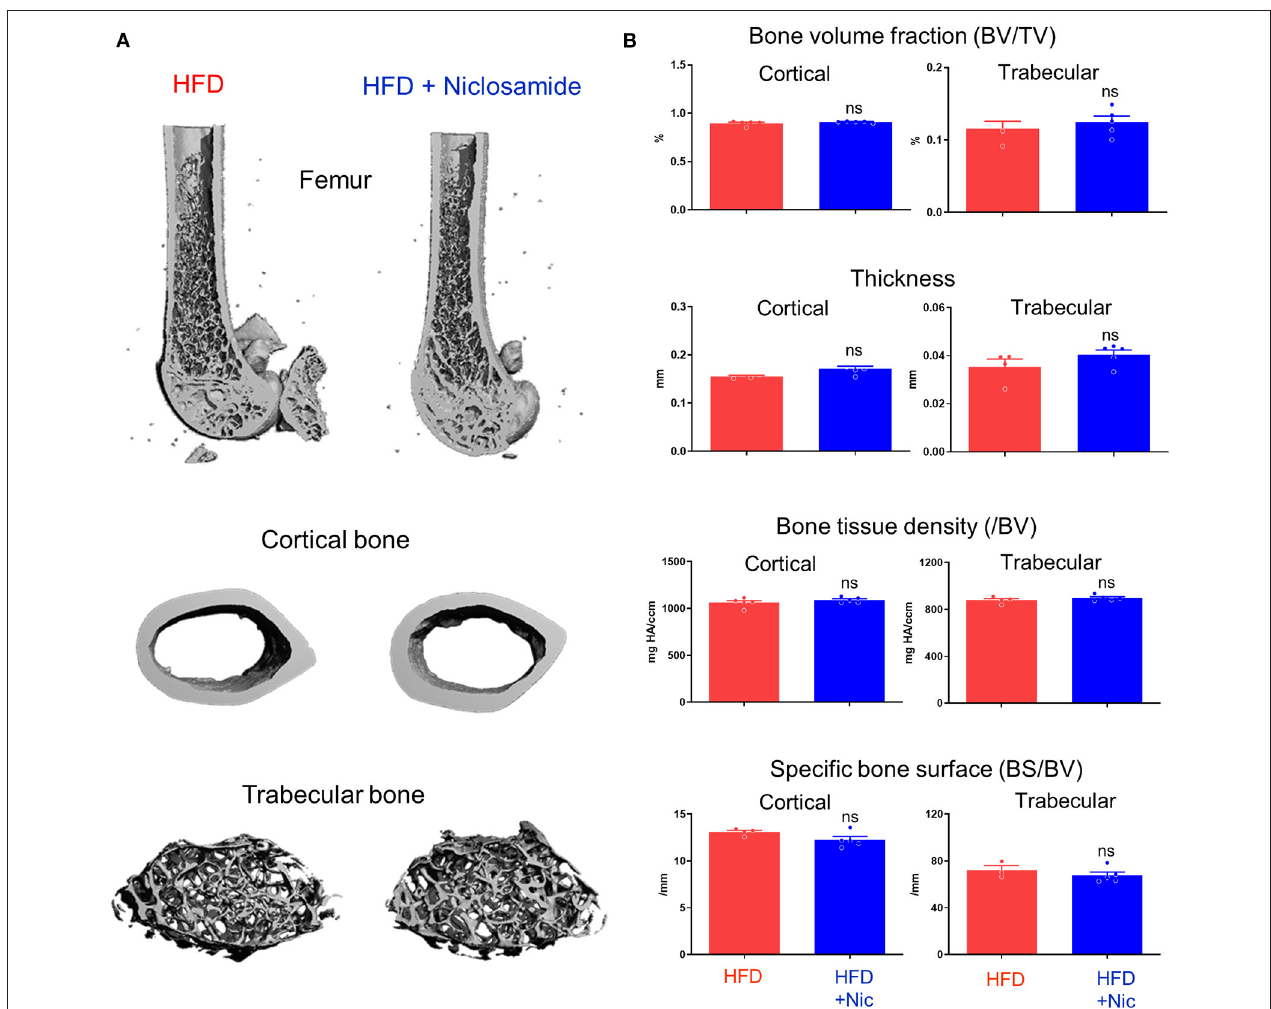
FIGURE 5 | Niclosamide does not alter bone density in Ldlr − / − mice fed with HFD. (A) Representative three-dimensional images of femur, cortical and trabecular bones from mice fed with HFD or HFD containing niclosamide. (B) Cortical and trabecular bone parameters measured by micro-CT. BV/TV, percentage bone volume (BV) in total volume (TV). Bone tissue density normalized by bone volume (/BV). Specific bone surface (BS) normalized by BV. N = 5 mice per group, error bars represent mean ± SD, analyzed by the Student’s t -test, ns indicates not